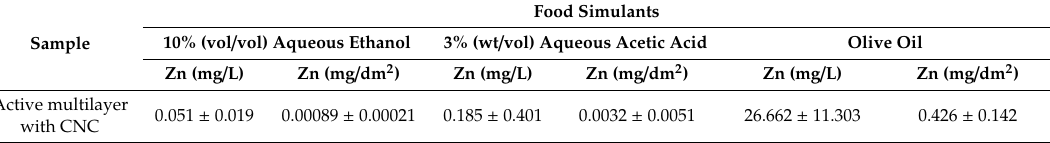
Table 7. Determination of the amount of zinc (Zn) migrated from the active multilayer films with cellulose nanocrystal (CNC) coating into di ff erent food simulants after an incubation period of 10 days at 40 ◦